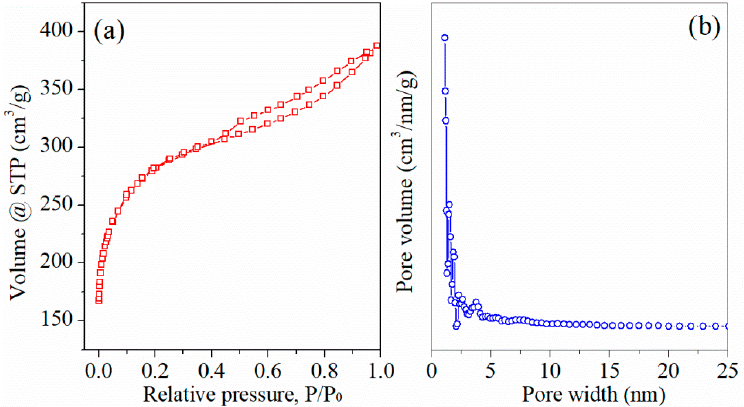
Figure 11. N 2 adsorption/desorption isotherms ( a ) and pore size distribution using DFT model ( b ) of the reduced AC-m.